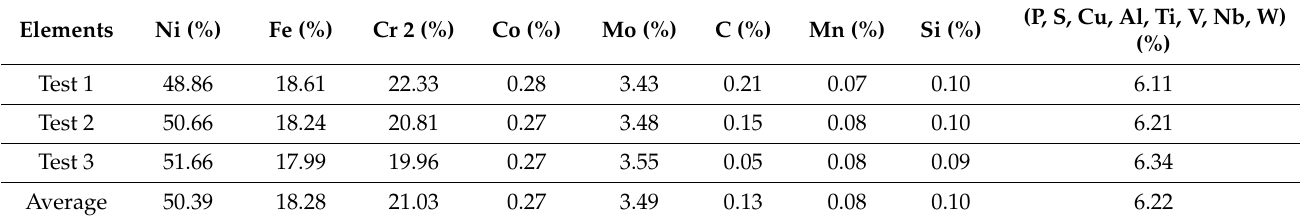
Table 3. Chemical composition of the substrate obtained via GDOES.